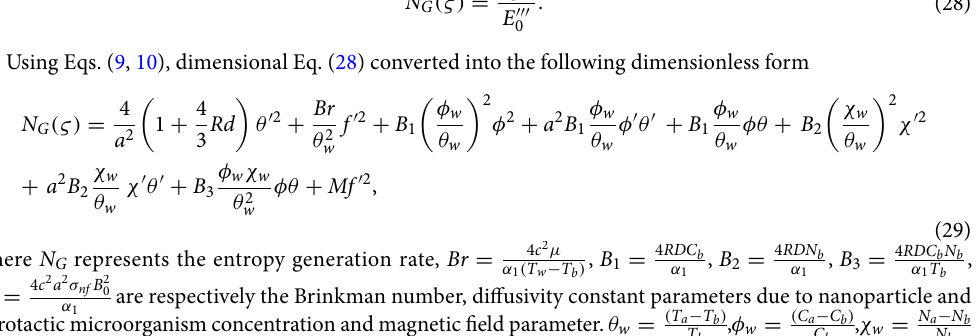
gyrotactic microorganism concentration and magnetic field parameter. θ w